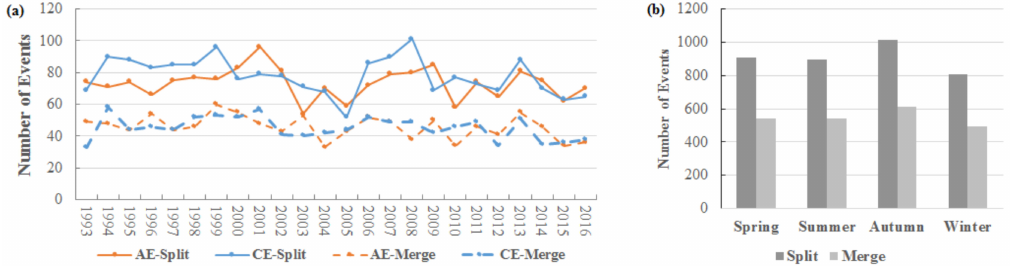
Figure 6. The statistics of splitting and merging events of CPAE and CPCE by year ( a ) and season ( b